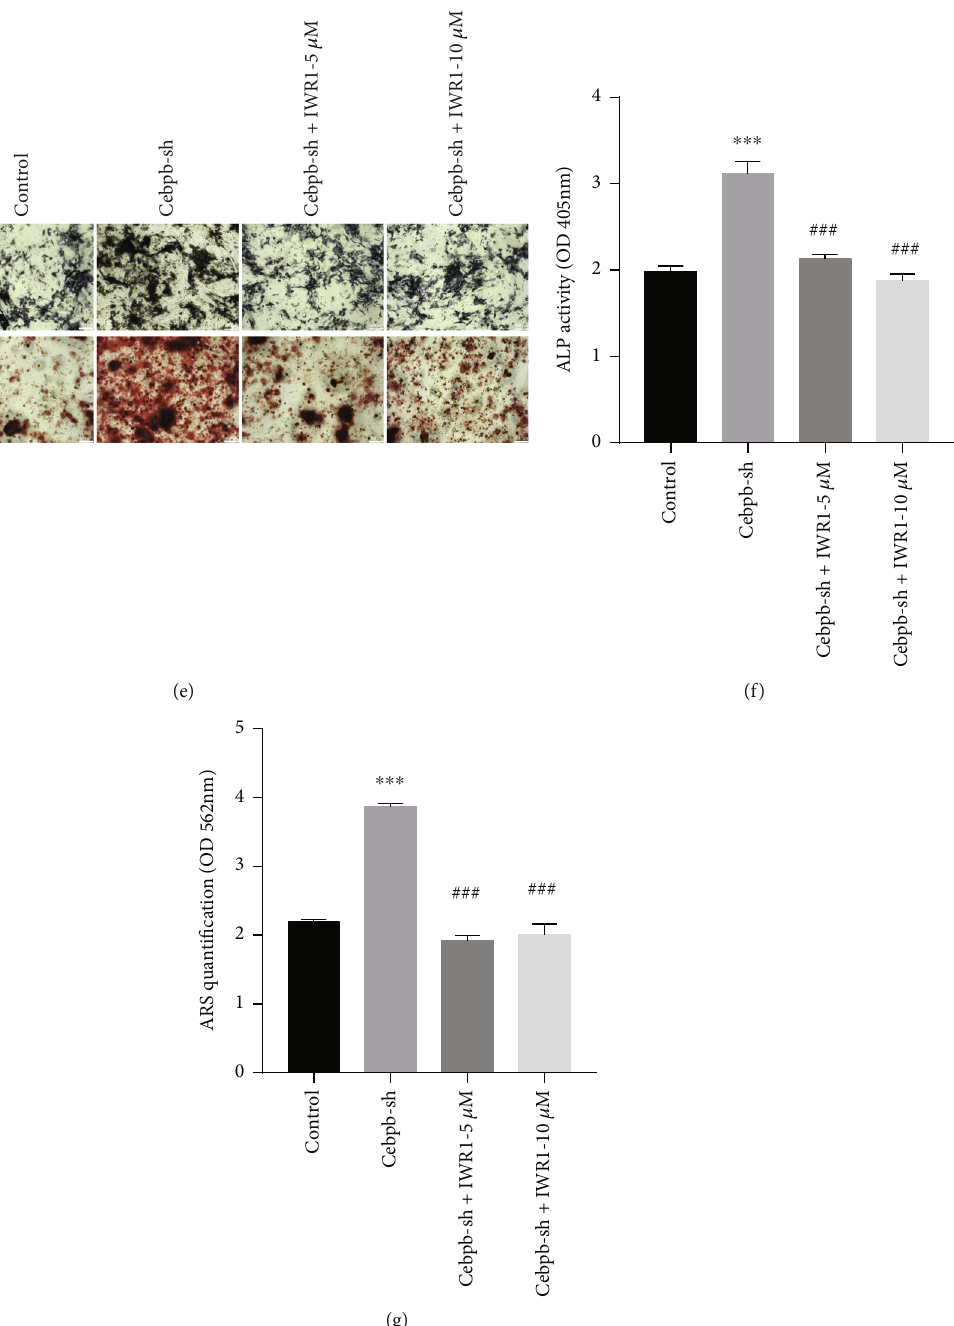
Figure 4: Cebpb knockdown activated WNT signaling in mSSC osteogenic di ff erentiation. (a) Expression of osteogenic di ff erentiation signaling proteins determined by western blot in the Cebpb inhibition group and the control group. (b) Quanti fi cation of result (a). (c) Expression of WNT signaling and osteogenic di ff erentiation proteins determined by western blot in the control, Cebpb inhibition, and WNT signaling inhibition groups. (d) Quanti fi cation of result (c). (e) Alizarin red S staining and alkaline phosphatase staining of mSSCs in the control, Cebpb inhibition, and WNT signaling inhibition groups. Scale bar: 200 μ m. (f) Quanti fi cation of alizarin red S staining of result (e). (g) Quanti fi cation of alizarin red S staining of result (e). Cebpb-sh: mSSCs stably expressing the Cebpb-shRNA1 and Cebpb- shRNA2 sequence. ∗ p < 0 : 05 compared with the control group, ∗∗ p < 0 : 01 compared with the control group, ∗∗∗ p < 0 : 001 compared with the control group, # p < 0 : 05 compared with the Cebpb-sh group, ## p < 0 : 01 compared with the Cebpb-sh group, and ### p < 0 : 001 compared with the Cebpb-sh group. IWR1: inhibitor of WNT